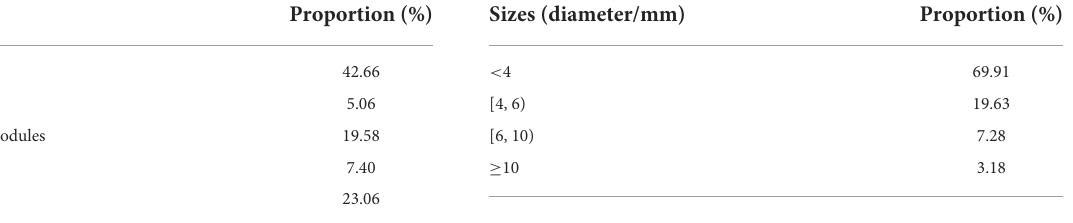
TABLE 1 The proportion of different types of nodules. TABLE 2 The proportion of different sizes of